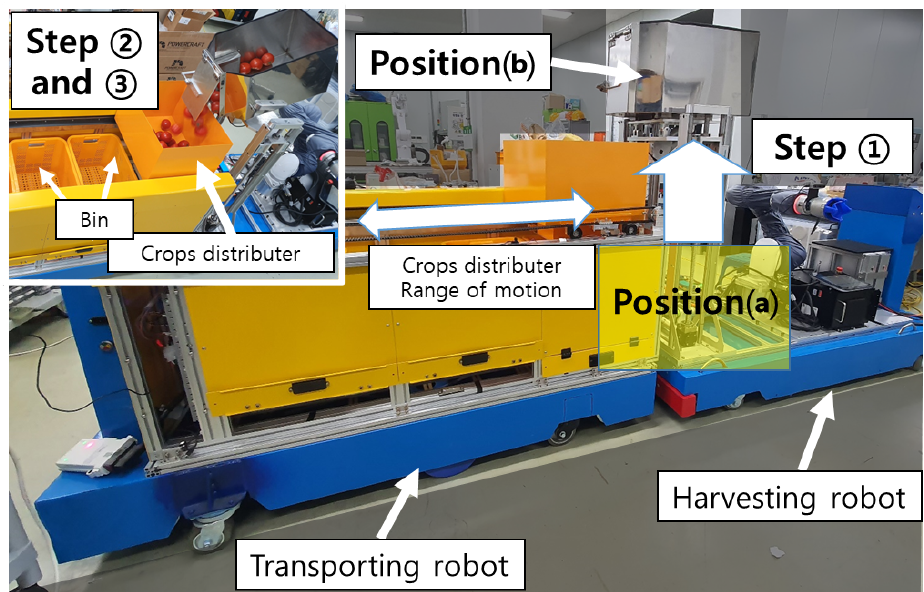
Figure 4. Harvested crops delivering from a harvesting robot to transporting